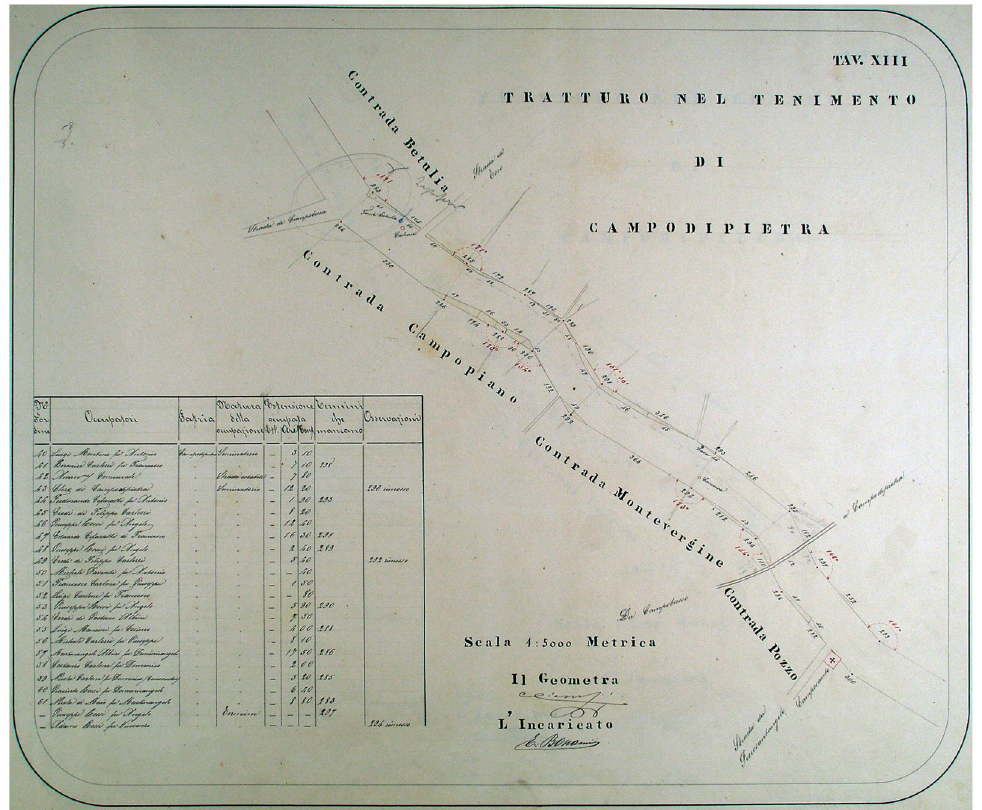
Figure A3. Details of Bonamici’s reinstatement, table XIII. The map reports the tratturo’s boundaries, the distances in meters among milestones, the angles included between two milestones (red ink) and the presence of squatting (yellow ink). The details of squatting are listed in the table. Authorization to publish n. 0004086/28.28.00/1 of 2016.02.20 granted by the Director of Archivio di Stato di